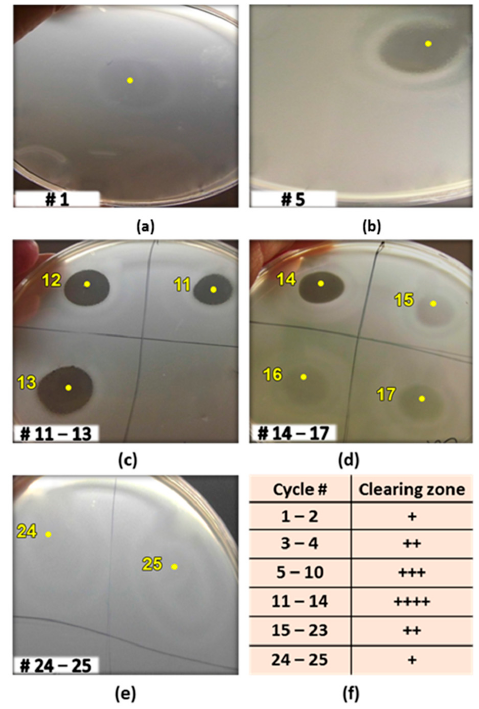
Figure 2. The antibacterial activity of the cell-free supernatant obtained by sequential batch cultivation of the immobilized cells of Geobacillus sp. ZGt-1 against G. stearothermophilus strain 10 at 60 ◦ C, at the end of ( a ) cycle # 1; ( b ) cycle # 5; ( c ) cycles # 11, 12, and 13; ( d ) cycles # 14, 15, 16, and 17; ( e ) cycles # 24 and 25. The yellow dot denotes the site where the supernatant was spotted; and ( f ) Summary of the antibacterial activity over the 25 cycles, the number of + symbols representing increasing degree of antibacterial